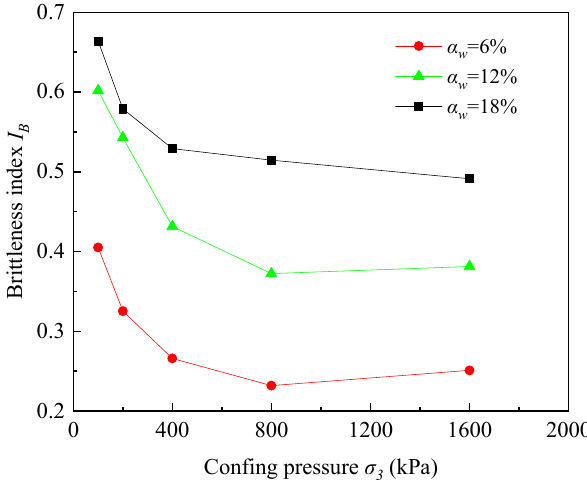
Figure 6. Variation in the brittleness index with confining pressure (curing time: 28 days).